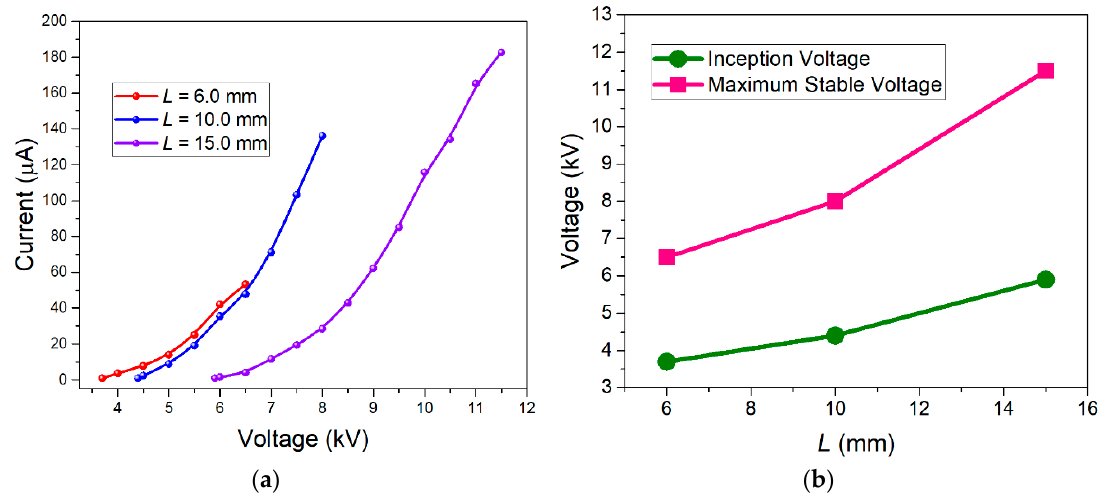
Figure 4. Electrical characteristic of the ionic wind device under three different needle-ring distances: ( a ) variation of discharge current with the applied voltage; and, ( b ) inception voltage and maximum stable voltage.